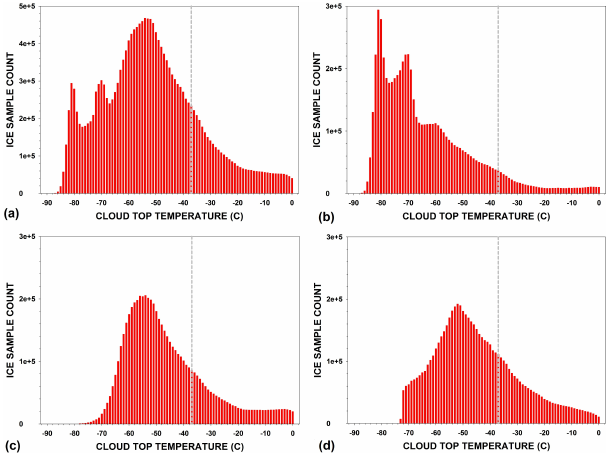
Figure 4. Cumulative probability densities between − 37 and 0 ◦ C for 2012 CALIOP V3.02 L2_CPro-5km clouds identified as ice with top height temperatures > − 37 ◦ C, including all data (black solid) and those subsets for observations found at latitudes θ ≤ | 30 ◦ | (red dashed), | 30 ◦ | < θ ≤ | 60 ◦ (green dashed) | and | 60 ◦ | < θ (yel- low